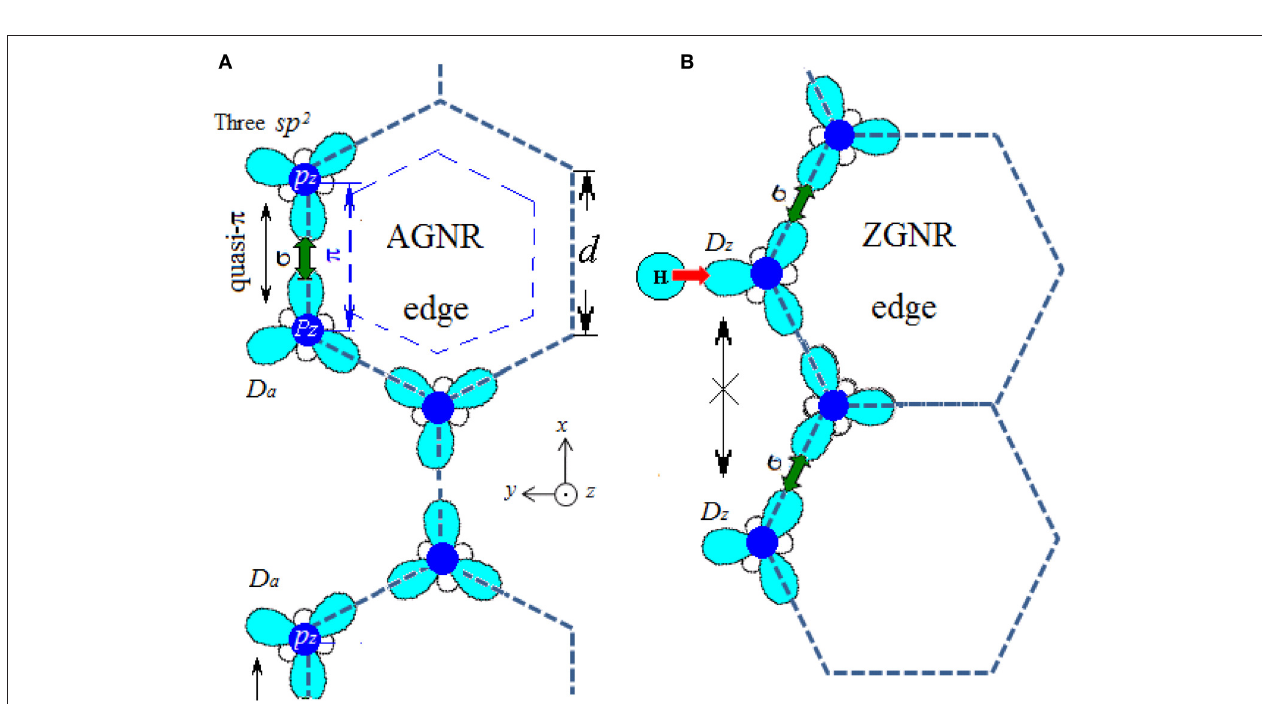
FIGURE 10 | Hybrid sp 2 orbitals of carbon atom are plotted at edges of (A) AGNR and (B)